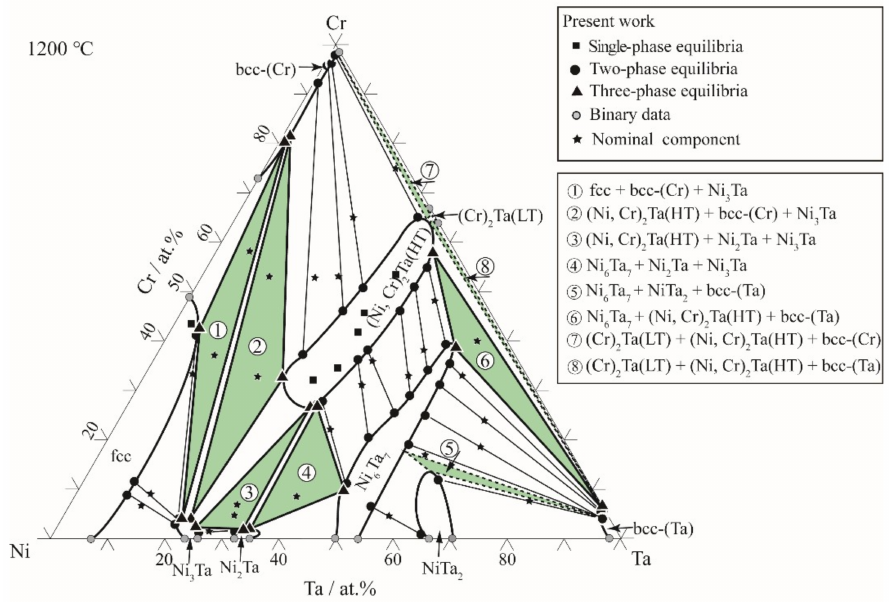
Figure 6. Experimentally determined isothermal section of the Ni-Cr-Ta system at 1200 ◦